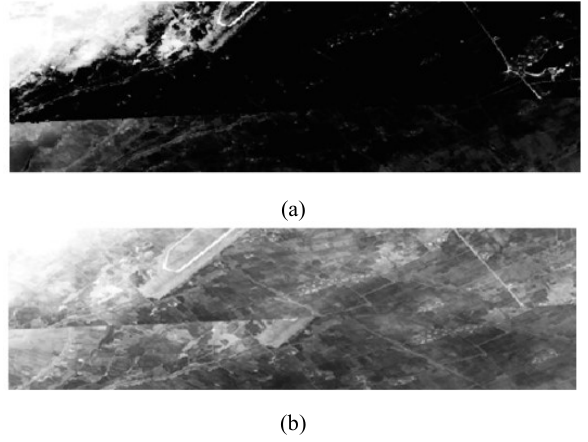
Figure 8. Radiation balance ((a) is before radiation balance, and (b) is after radiation balance)